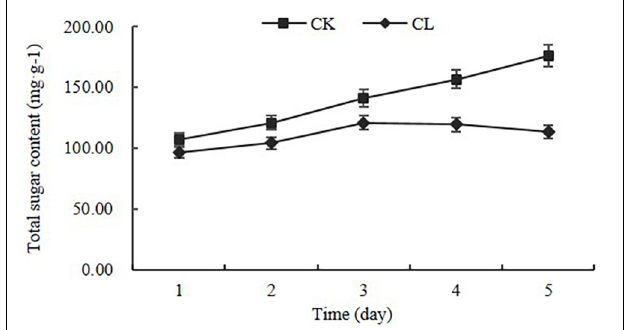
FIGURE 2 | Changes in total sugar content in the crude toxin treatment (CL) and the control (CK). Error bars represent the standard errors for three replicates of total sugar